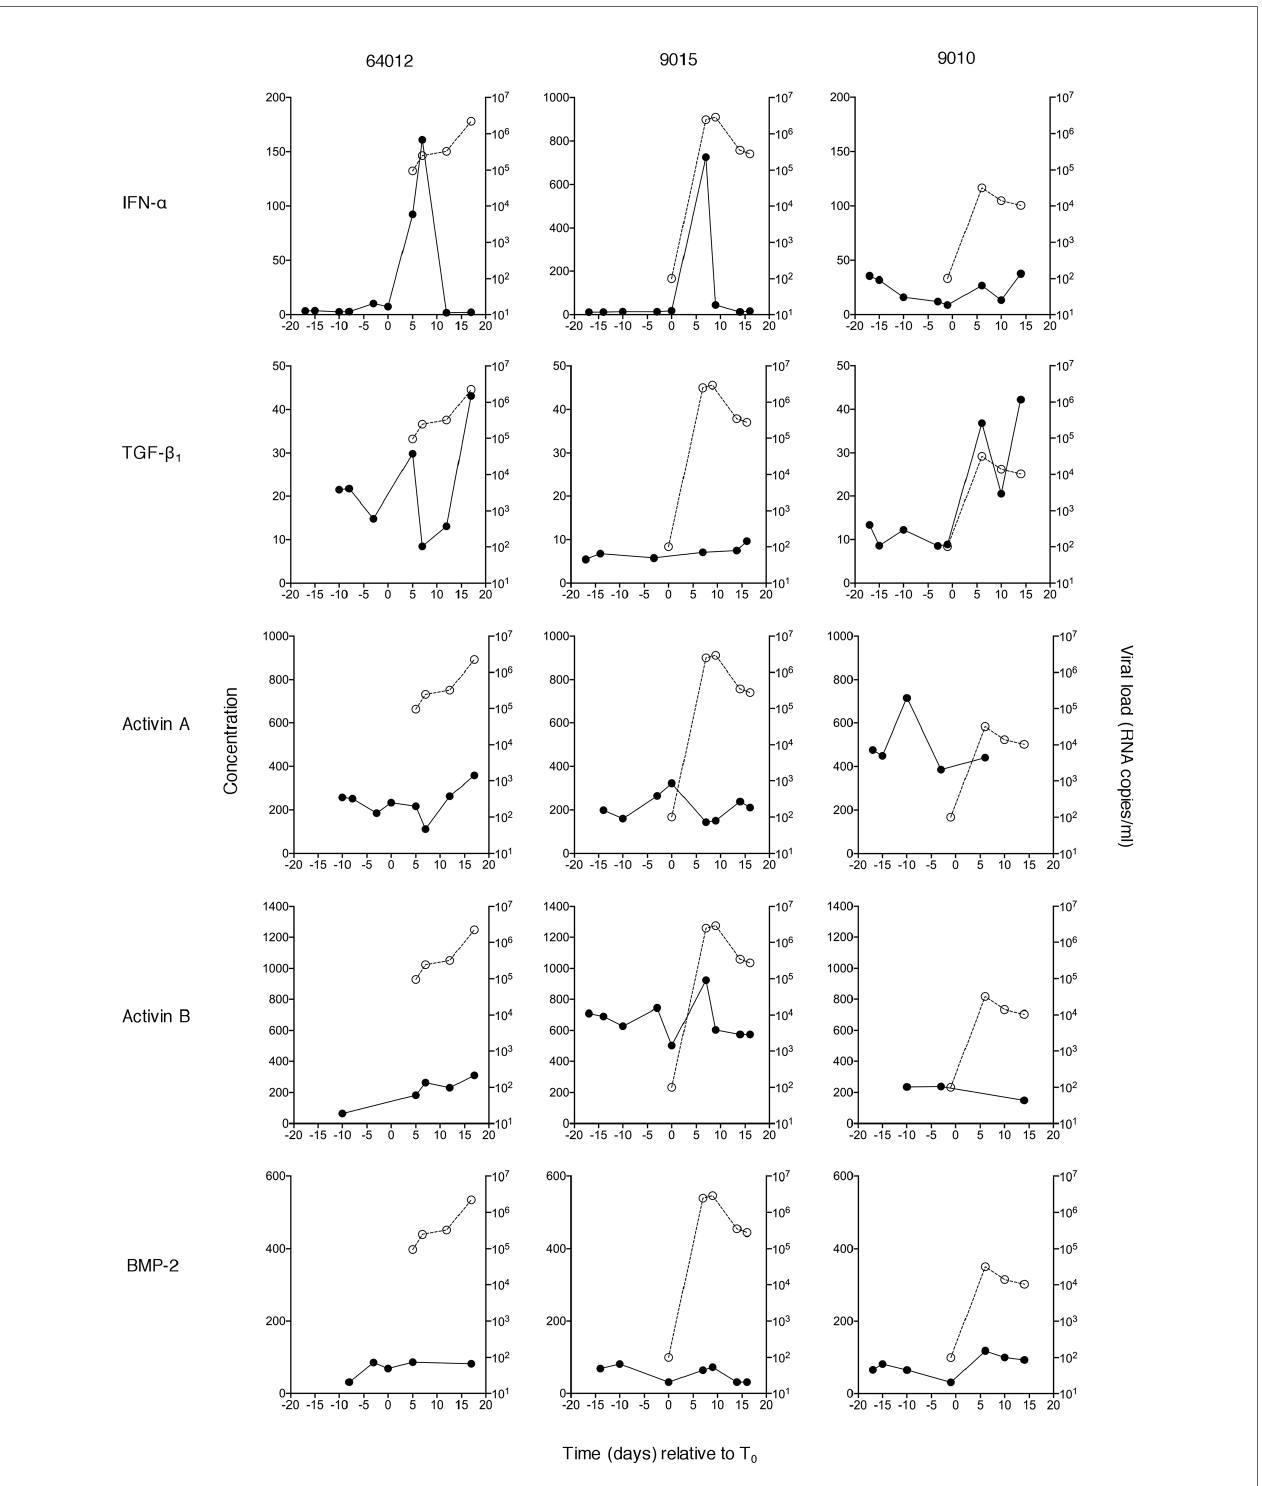
FIGURE 1 | Plasma concentrations of IFN- a and TGF- b superfamily cytokines at serial time-points during acute HIV-1 infection in three donors. Circulating concentrations of TGF- b 1 , activin A, activin B and BMP-2 were measured in serial plasma samples collected at time-points both pre- and post-T 0 (the time-point when viral load fi rst reached detectable levels (100 RNA copies/ml)) from plasma donors who became acutely infected with HIV-1. Data from three representative subjects is shown. Plasma IFN- a levels in the same individuals (evaluated as part of a prior study (4) are shown for comparison. Closed circles/solid lines represent cytokine concentrations (pg/ml, except TGF- b 1 which is in ng/ml); open circles/dashed lines represent plasma viral load (RNA